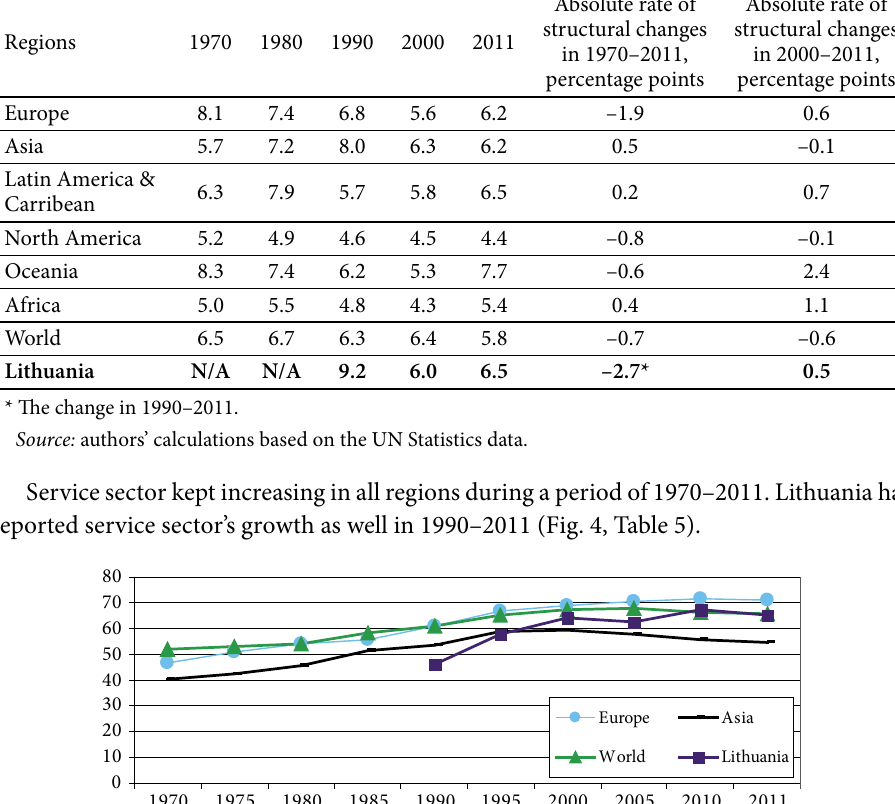
Table 4. Cоnstructiоn share оf tоtal value added, in percent Regions